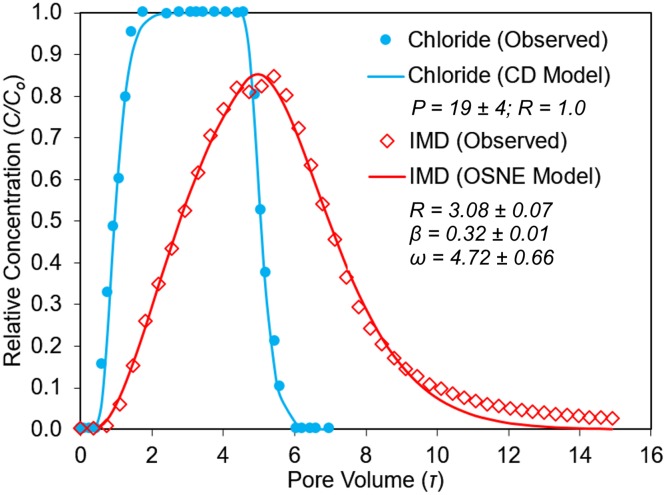
Imidacloprid (IMD) and tracer (Cl-) BTC from the Bh-horizon column and corresponding transport parameters.Solid lines indicate the optimized transport models (CD and OSNE).